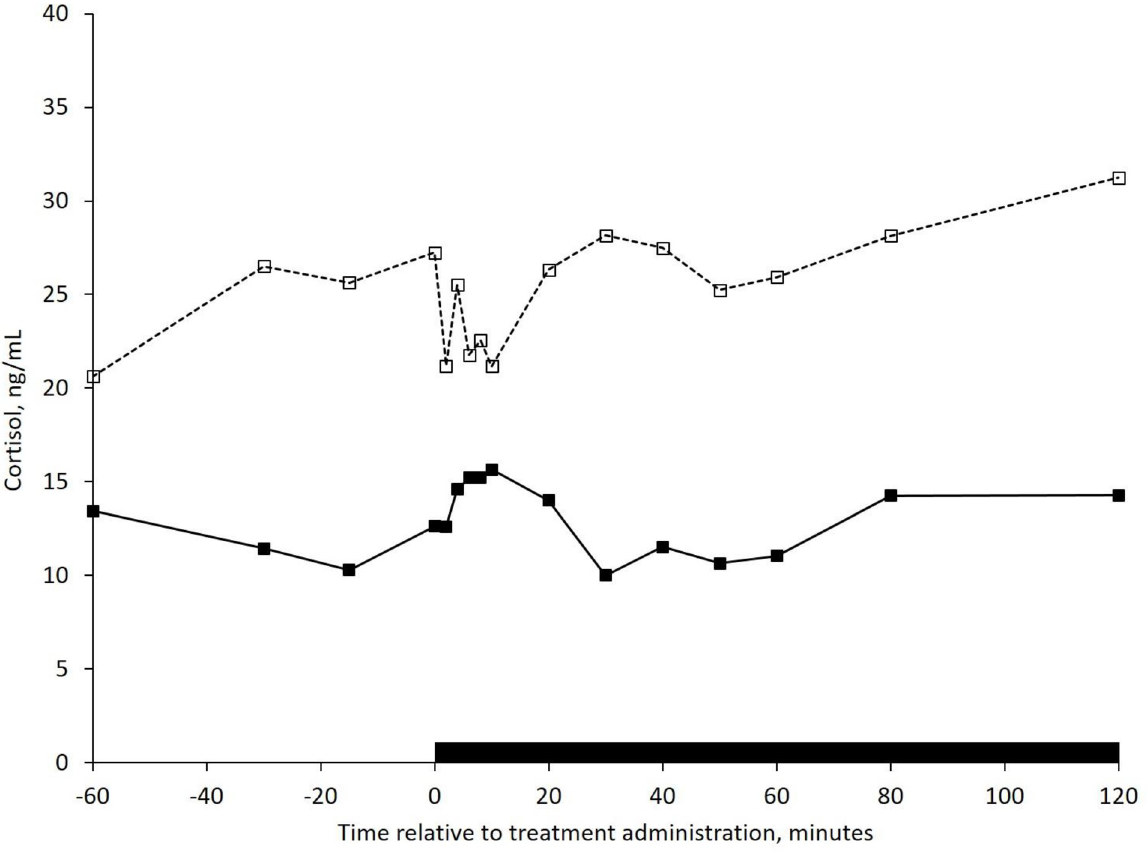
Fig 2. Mean plasma cortisol concentration in Bos taurus cows. Cows were lactating (L, ── ■ ── ; n = 8) or non-lactating (NL, – – □ – –; n = 10). Head restraint start time and duration are indicated by the black bar. The pooled SEM was 4.0. An effect of lactation ( P = 0.02) was detected, however there was no interaction between lactational status and intra-nasal treatment ( P =